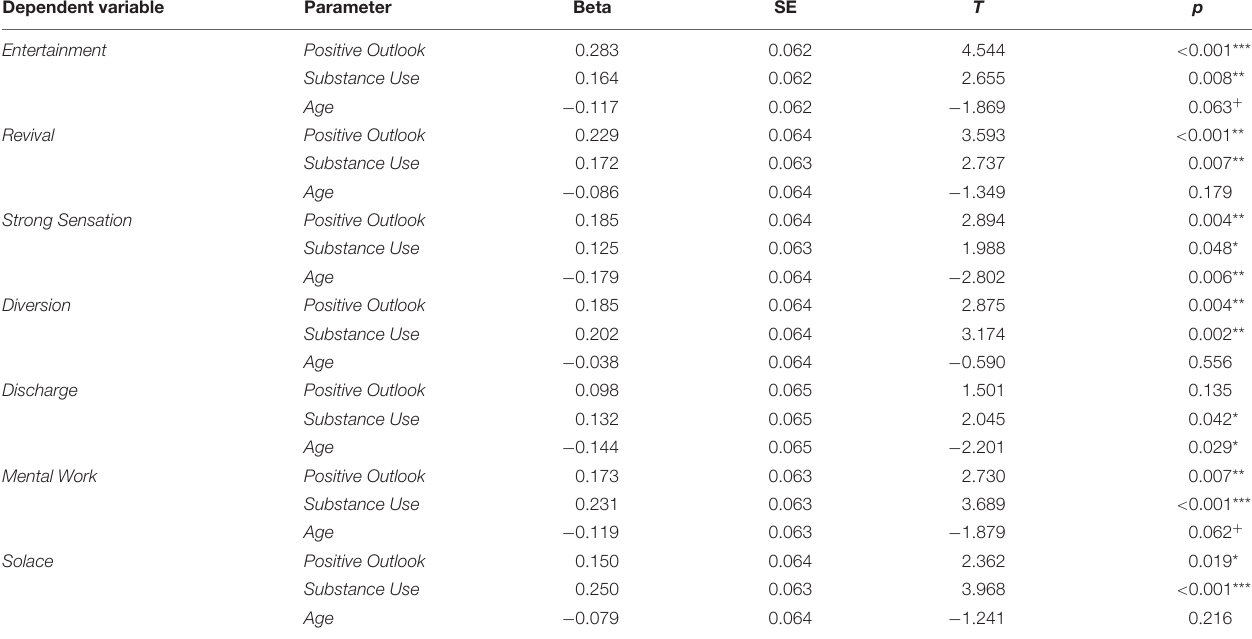
TABLE 8 | Parameter estimates of significant MMR